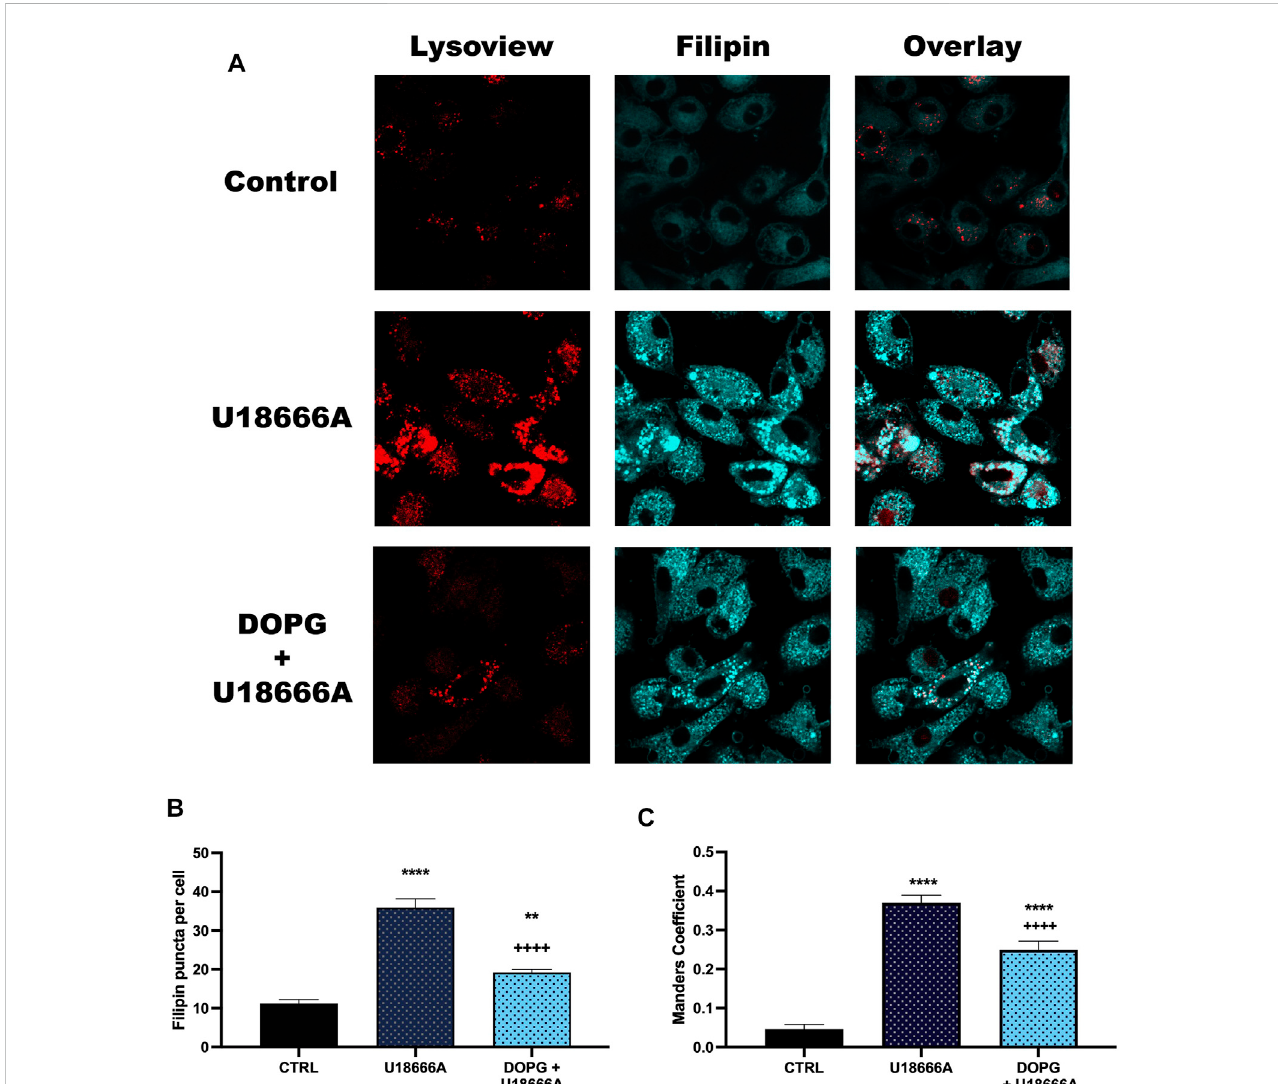
FIGURE 3 DOPG reduced U18666A fi lipin puncta. BMdM were treated with U18666A or DOPG + U18666A for 24 h. Cells were stained with Lysoview prior to fi xation and fi lipin staining. (A) Representative images of Lysoview and fi lipin stained BMdM. (B) Filipin puncta per cell quanti fi ed by ImageJ analysis. (C) Manders colocalization analysis of Filipin staining with Lysoview staining. Data expressed as mean ± SEM , n = 3 independent experiments. Analyzed by one- way ANOVA with Tukey's multiple comparisons test. ** p < 0.01 and **** p < 0.0001 compared to control untreated cells. ++++ p < 0.0001 compared to U18666A treated